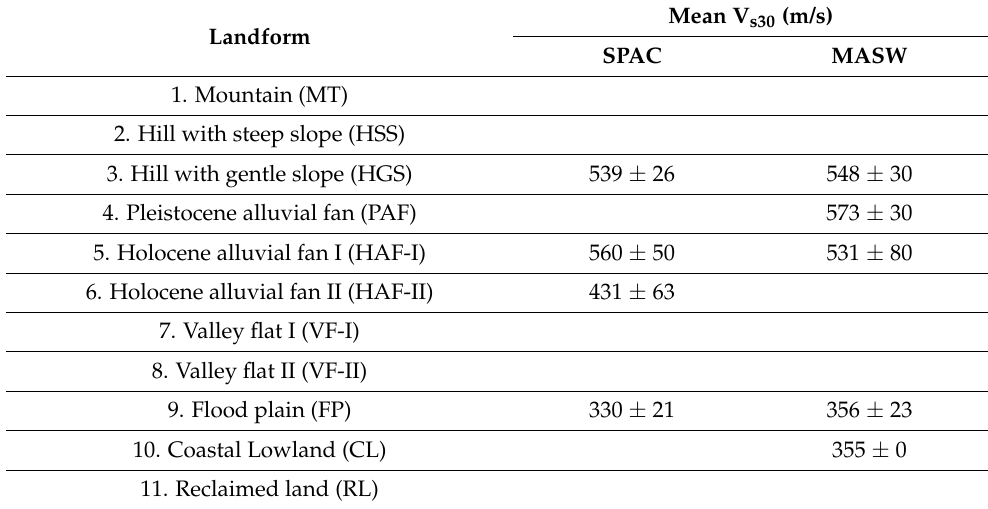
Table 3. ComparisonofthemeanV s30 valuesfromSPACandMASWmethodsfordifferentgeologicalunits.